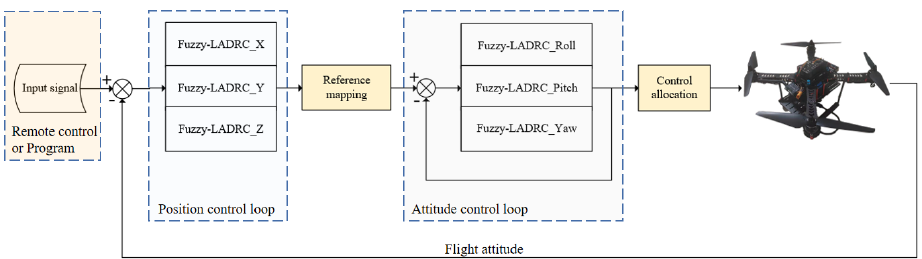
Figure 3. The control of UAV is a cascade feedback control system. The outer loop is position control, and the inner loop is attitude